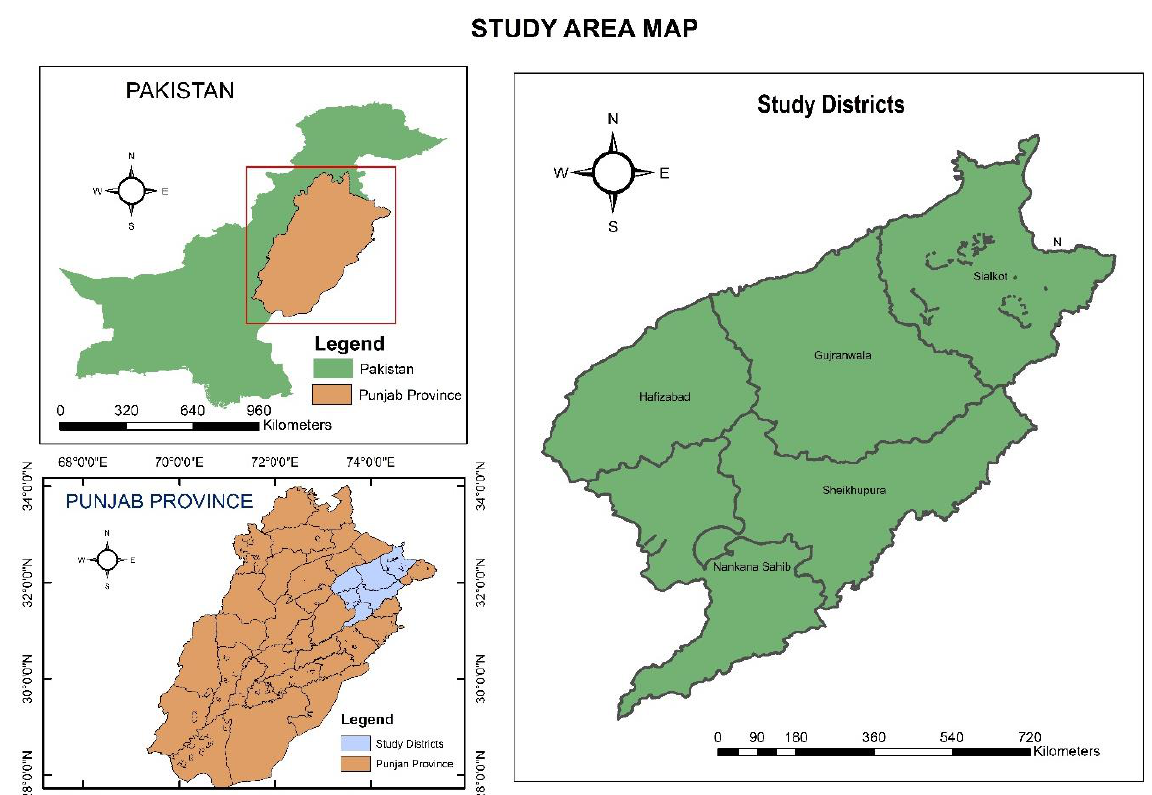
Figure 2. Geographical location of integrated assessment regions (5 stratum) with 155 farmers’ field in the Rice-Wheat cropping zone of Punjab, Pakistan.